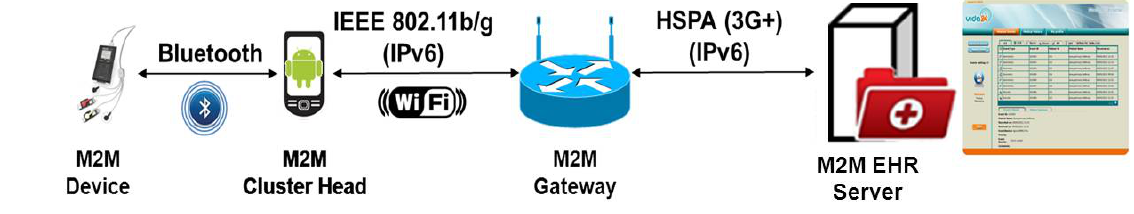
Figure 3. Platform overview. First step of the testbed